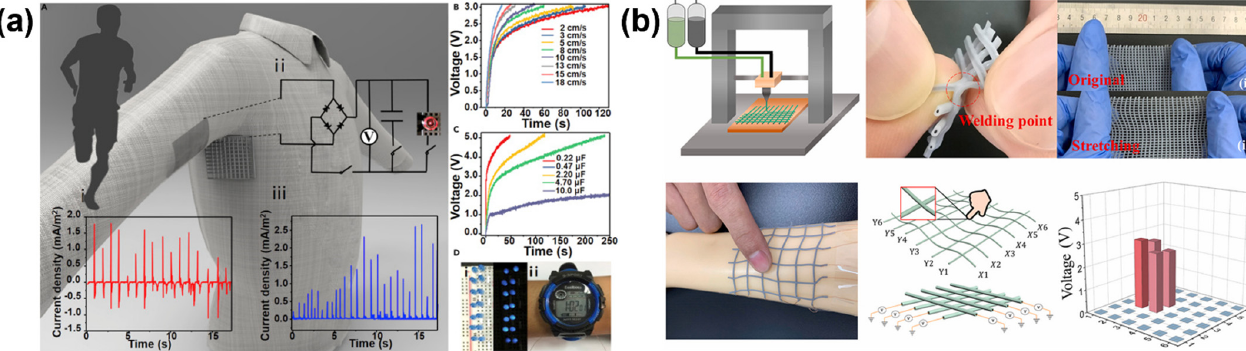
Figure 6. ( a ) Application of the 3D-Printed E-Textile for Energy Management ( A ) Schematic illus- tration showing smart clothes for energy management and its performance. Inset ( i ) the output I sc density of a smart gridline pattern printed on the underarm sleeve of a shirt generated by an arm moving. Inset ( ii ) the rectifying circuit diagram of the power system. Inset ( iii ) the rectified output I sc density of the smart pattern; ( B ) Charging curves of a capacitor (3.3 µ F) charged using the smart pattern displaced at different speeds; ( C ) Charging curves of different capacitances charged using the smart pattern with a displacement speed of 13 cm/s; ( D ) Photographs showing ( i ) LEDs and ( ii ) an electrical watch driven by the power generated by the 3D-printed E-textile. ( b ) stretchable elastic fibers for tactile sensor of electronic skin. Inset ( i ) original, ( ii ) Stretching.